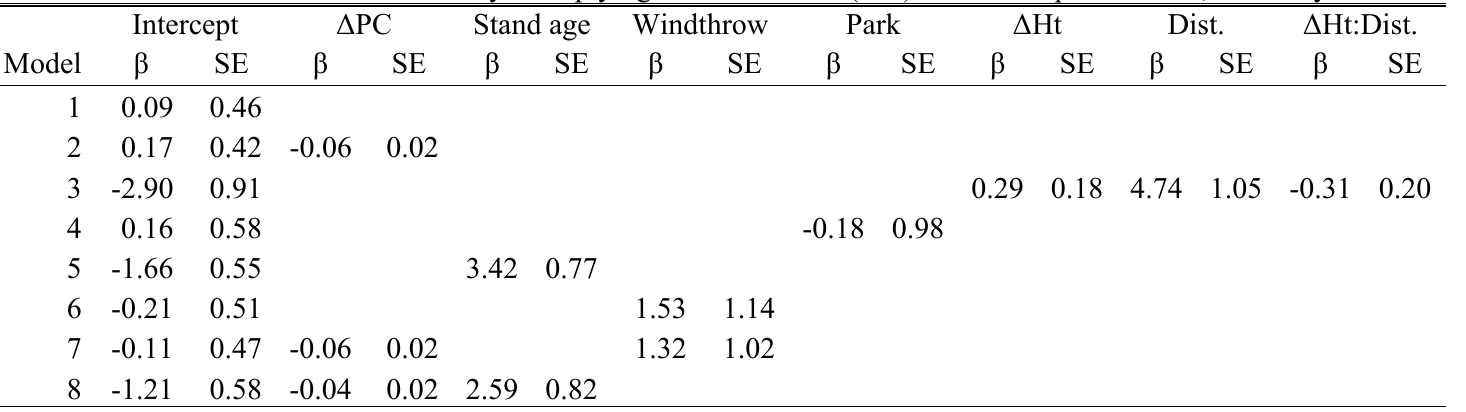
Table A2.10 Parameter estimates for models examining variation in stand-level trends (between circa 1994 and 2014) in abundance White- throated Sparrow in aspen dominated mixedwood forests in central Saskatchewan. 85% Confidence Intervals can be obtained as β ± 1.44* SE. NOTE: Parameter values were rescaled by multiplying with a constant (100) for ease of presentation, divide by 100 to obtain